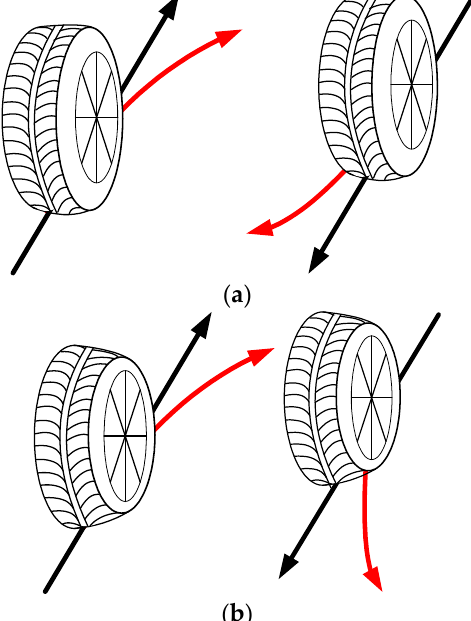
Figure 3. Acting direction of residual cornering force ( a ) ply-steer force ( b ) conicity force.